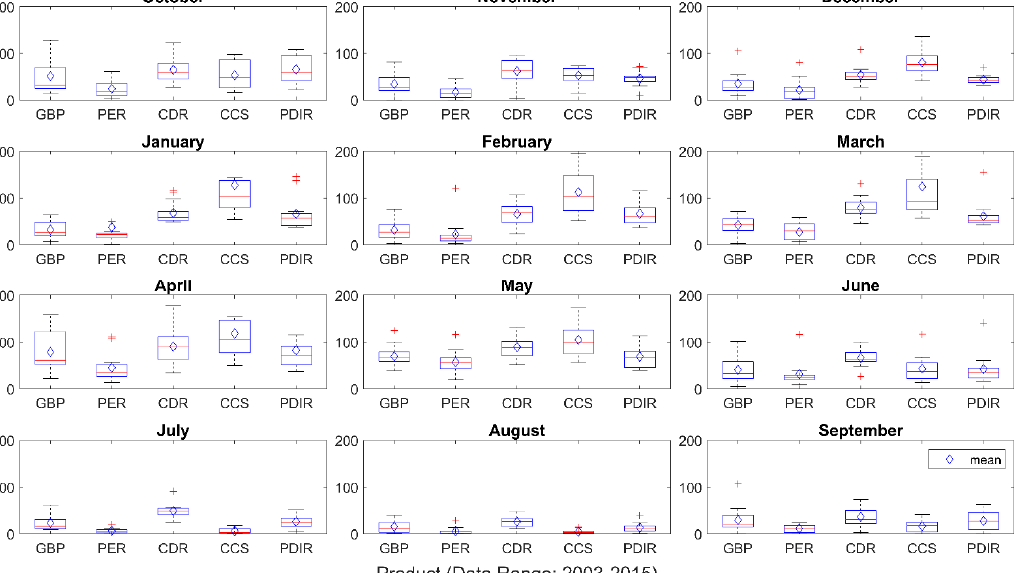
Figure 7. Monthly PVE of SBP data set with regression analysis (where p < 0.005 except for PER ( p = 0.6526), CCS ( p = 0.2377) during the accumulation season, and for CCS ( p = 0.1403) during the melt- ing season). * GBP: Gauge-based Precipitation, PER: PERSIANN, CDR: PERSIANN-CDR, CCS: PERSIANN-CCS, PDIR: PERSIANN-PDIR-Now.